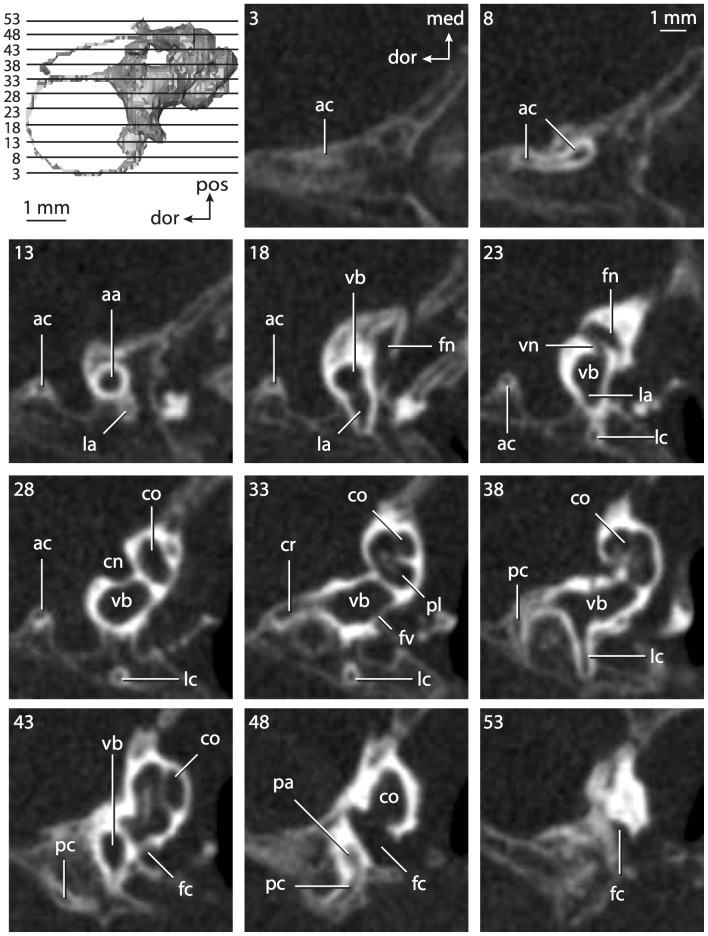
CT slices through ear region ofAtelerix albiventris.Abbreviations listed at the end of the Materials and Methods section.